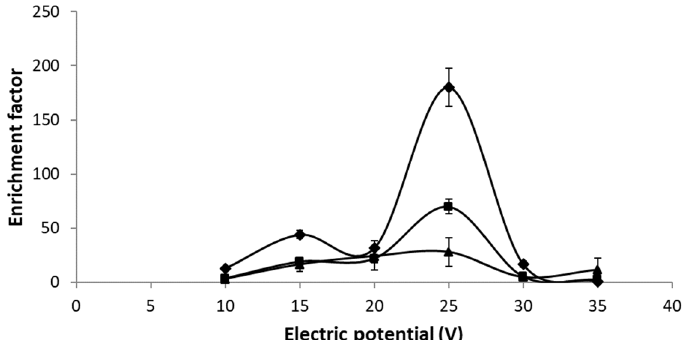
Figure 2. Effect of applied electric potential and fiber length on enrichment factor. Sample pH = 5.5, DEHPA 0.9 M, HNO 3 1.9 M, time of extraction 15 min, and stirring rate 500 rpm. Fiber length ♦ 3 cm, ■ 4 cm, ▲ 5 cm.